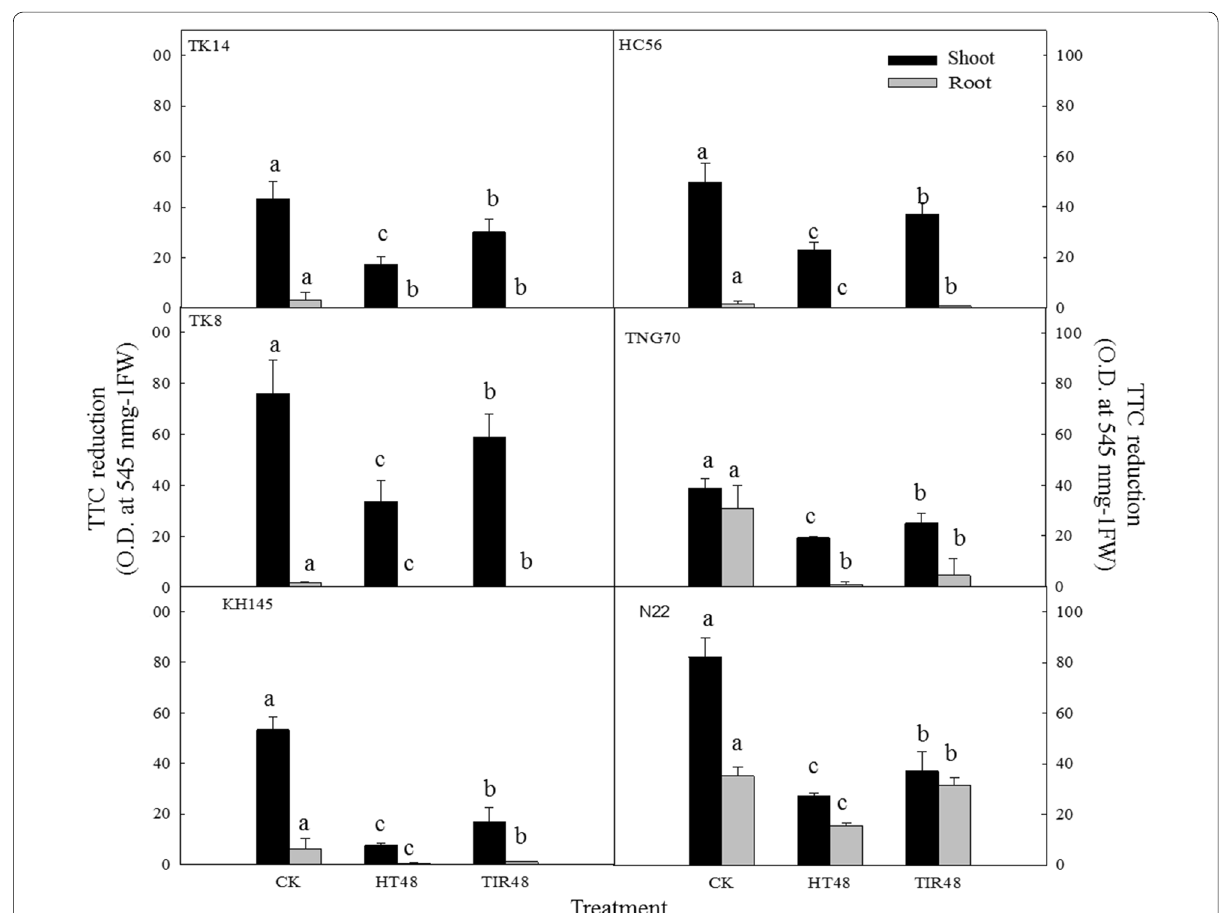
Fig. 9 TTC reduction (O.D. at 545 nm g − 1 FW) of the shoots and roots of the seedlings under HT48 and TIR48 (O.D./g); different letters above the same color bars indicate a significant difference at the 0.05 level